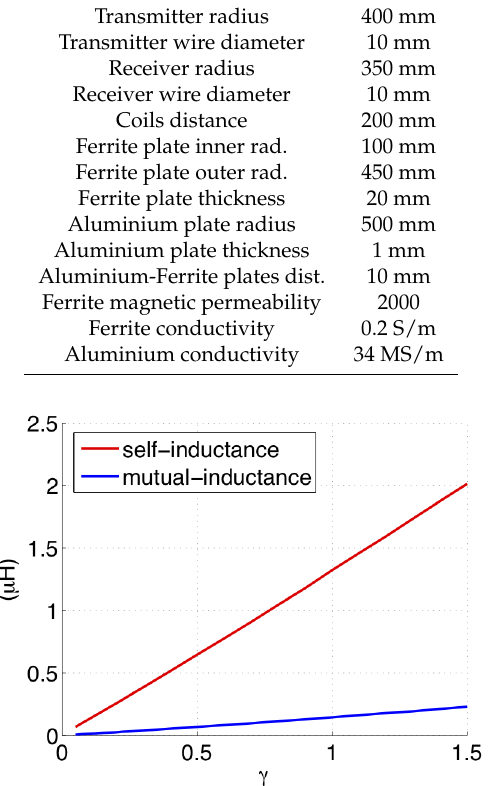
Figure A4. Mutual inductance and transmitter self-inductance versus the scaling factor for ferrite thickness proportional to γ 2 .